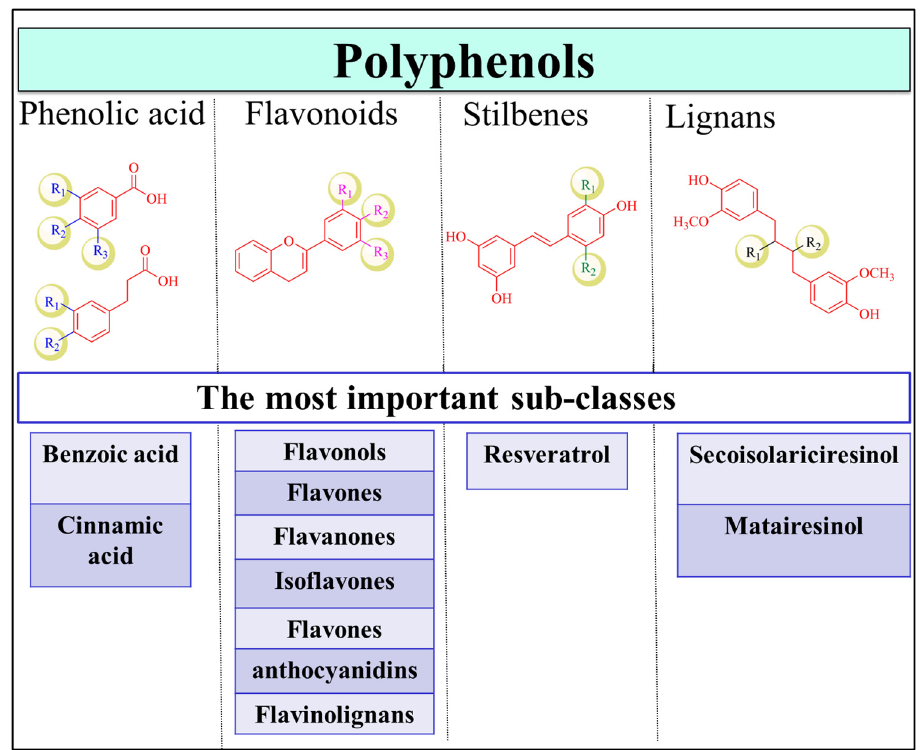
Figure 1. Polyphenol classification. The classes of polyphenols include phenolic acids, flavonoids, stilbenes, and lignans. Examples of important subfamilies of each class are shown.